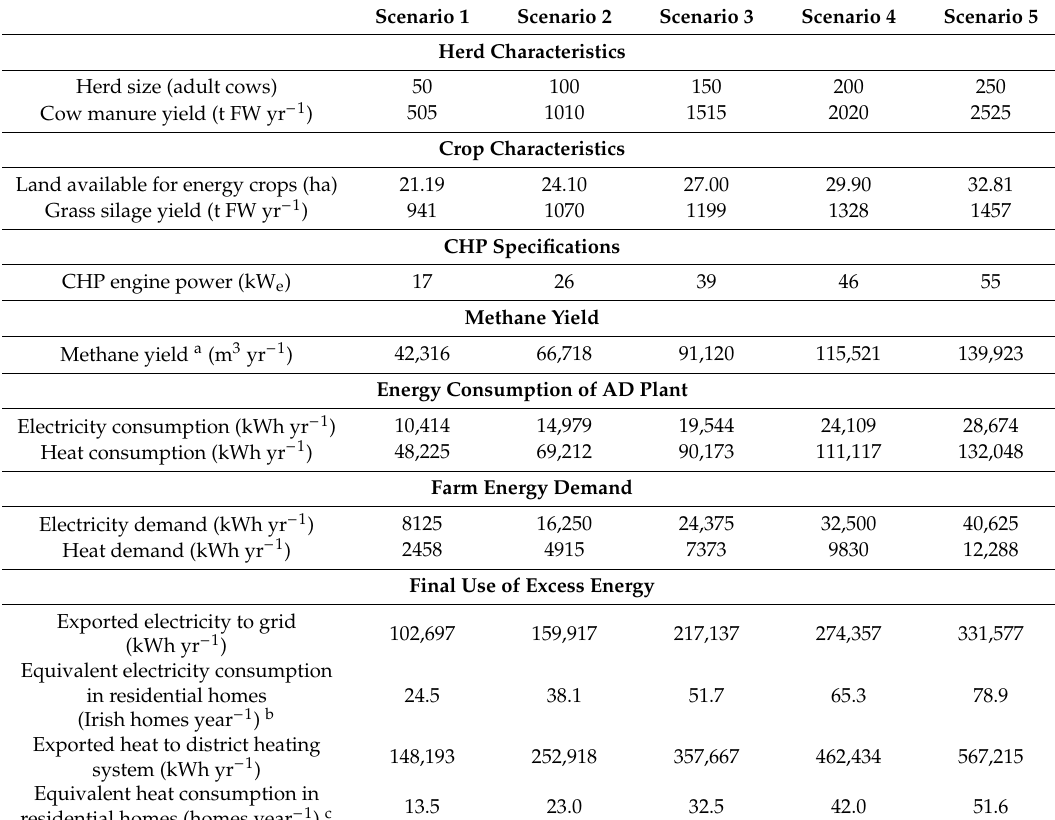
Table 5. Technical characteristics of scenarios under study.